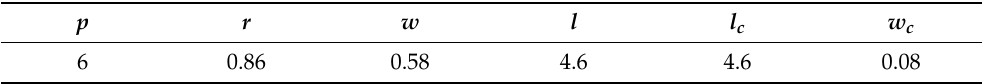
Figure 1. Unit cell of the proposed reflective converter. ( a ) Top view of the rectangular-slot polarization converter with physical parameters and ( b ) side view with substrate properties. Table 1. Optimized value (in mm) of the reflective metasurface unit